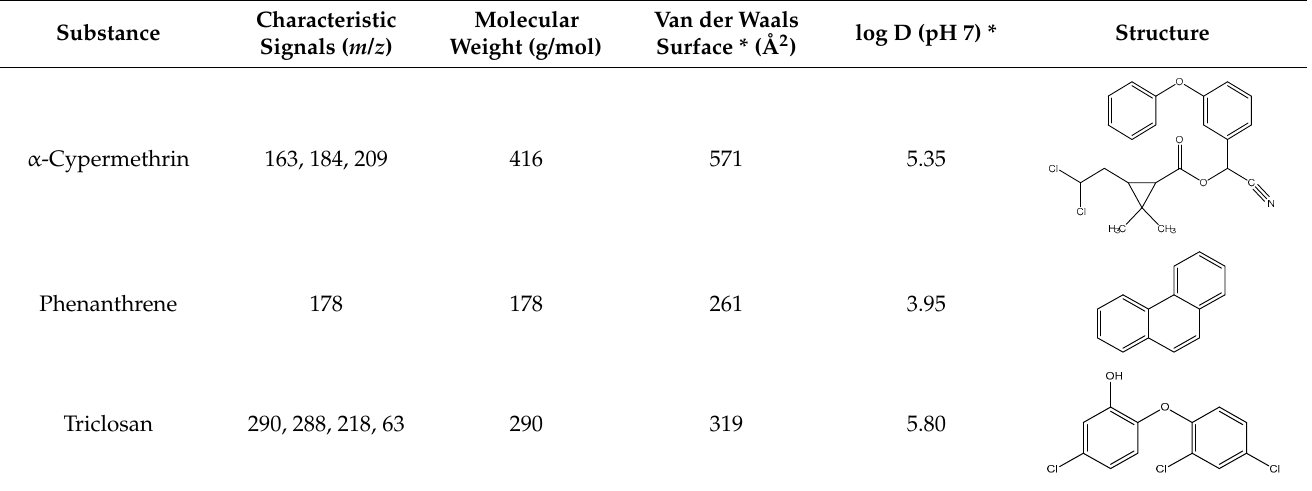
Table 1. Characteristic signals for MS analysis, properties, and structure of selected TOrCs.